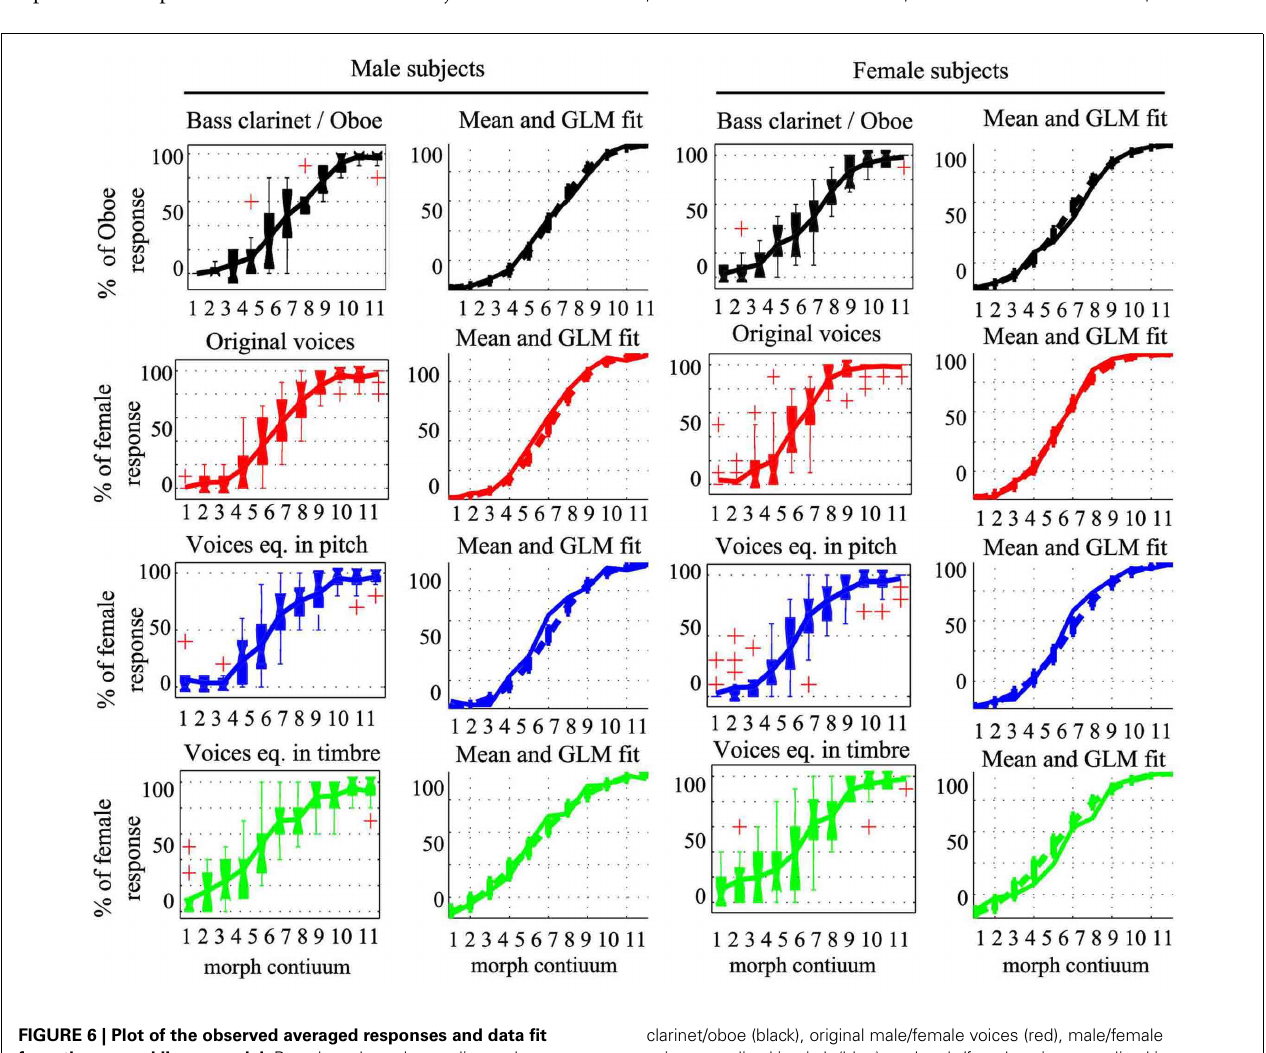
FIGURE 6 | Plot of the observed averaged responses and data fit from the general linear model. Box plots show the median and interquartile range with whiskers extending to the most extreme points. Crosses denote outliers (above 1.5* the 75th percentiles or 1.5*below the 25th percentile). Mean responses in the bass